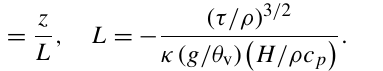
(cid:16) − ∂u/∂zu (cid:48) w (cid:48)